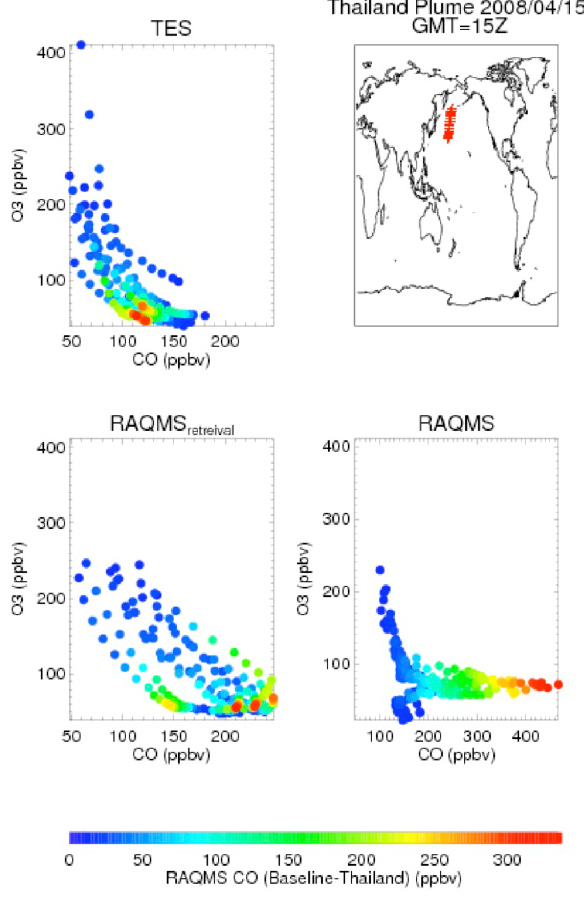
Fig. 11b. Same as Fig. 11a but downwind of Thailand